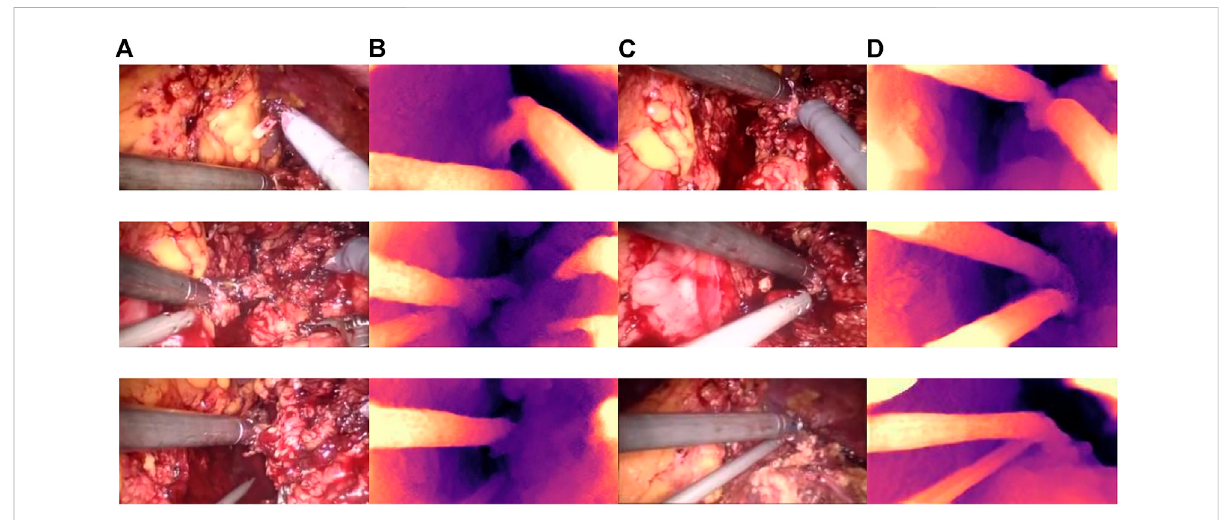
FIGURE 8 Parallax estimation results. (A,C) : endoscopic test images. (B,D) : the parallax image obtained using the HS-RESNET.